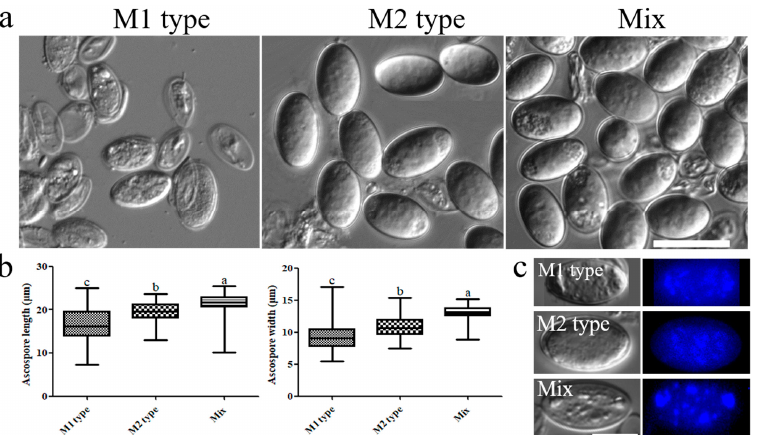
Figure 5. Morphology analysis of the ascospore in different types of fruiting bodies. ( a ) Morphology of the ascospores from different types of fruiting bodies, bar = 20 µ m; ( b ) the size of the ascospores. Different letters indicate significant differences (Table S3.9 and 3.10), one-way ANOVA, p < 0.05; ( c ) photograph of 4’,6-diamidino-2-phenylindole (DAPI) staining of ascospores, bar = 10 µ